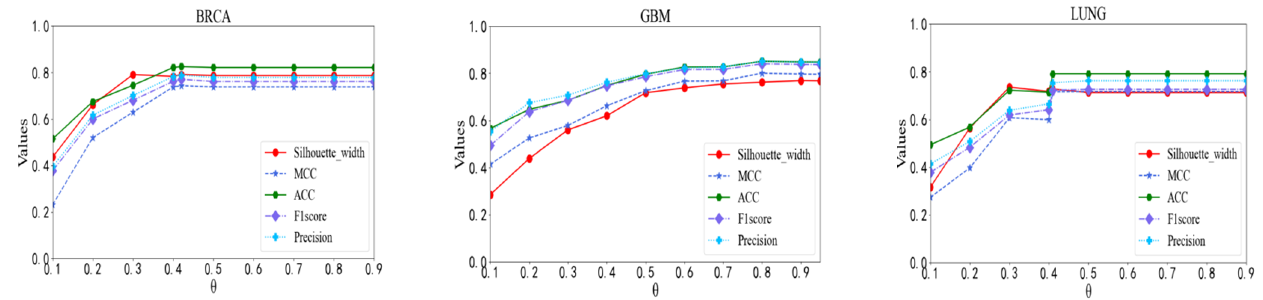
Figure 2. Performance comparison with respect to different correlation coefficient thresholds.